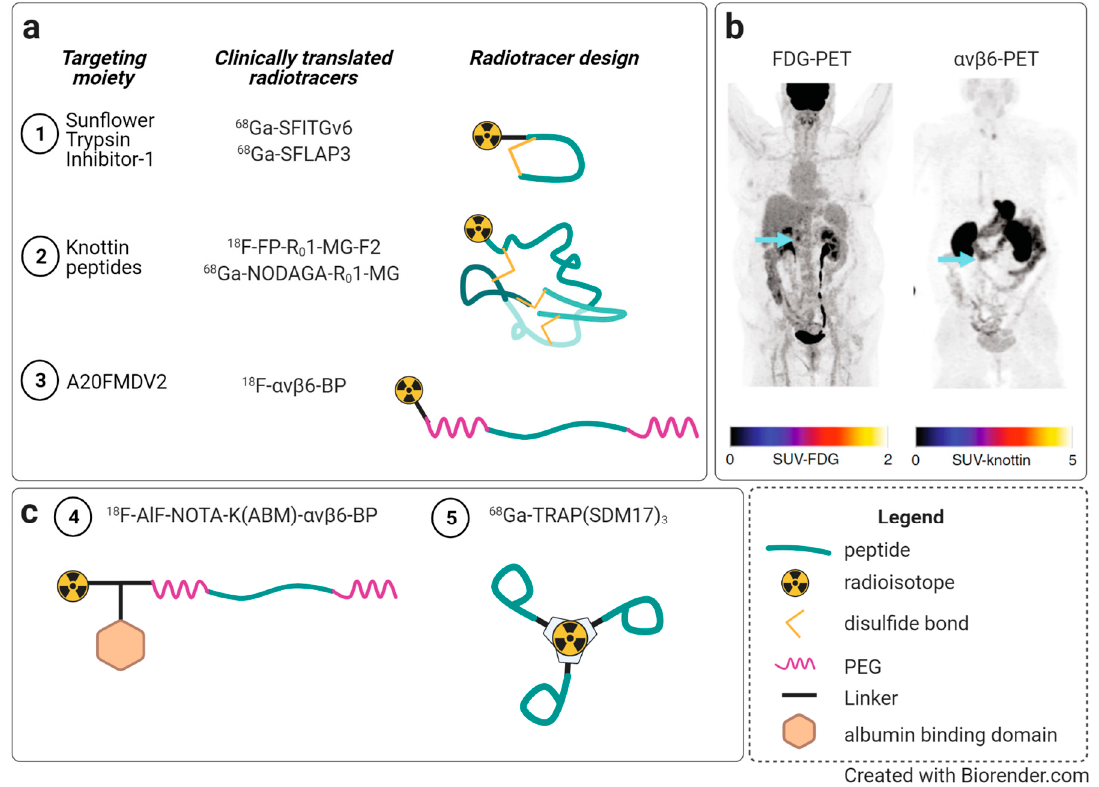
Figure 8. Recent advances in translational α v β 6-targeted Positron Emission Tomography (PET) imaging. ( a ) Clinically translated α v β 6-targeted radiotracers are based on different design approaches, such as disulfide bridged peptides ➀ , knottin peptides ➁ , and linear peptides ➂ . Further descriptions about these tracers are detailed in the text. ( b ) Comparison of [ 18 F]FP-R01-MG-F2 PET and [ 18 F]-FDG imaging in a patient with pancreatic cancer. The cyan arrow shows tracer accumulation at the head of the tumor (standardized uptake value (SUV)-knottin = 6.3). Several regions of relatively high accumulation were observed, including the kidneys, which are the main clearance route, and the stomach and small intestines, where integrin α v β 6 is expressed. Reprinted from Kimura et al. Nat Commun 10, 4673 (2019) under Creative Commons CC BY 4.0. ( c ) Design of recent preclinical probes to improve pharmacokinetics and increase tumor uptake. Introduction of an albumin binding domain increased circulation time and tumor uptake ➃ and trimerization of a peptide increased affinity and tumor uptake ➄ .